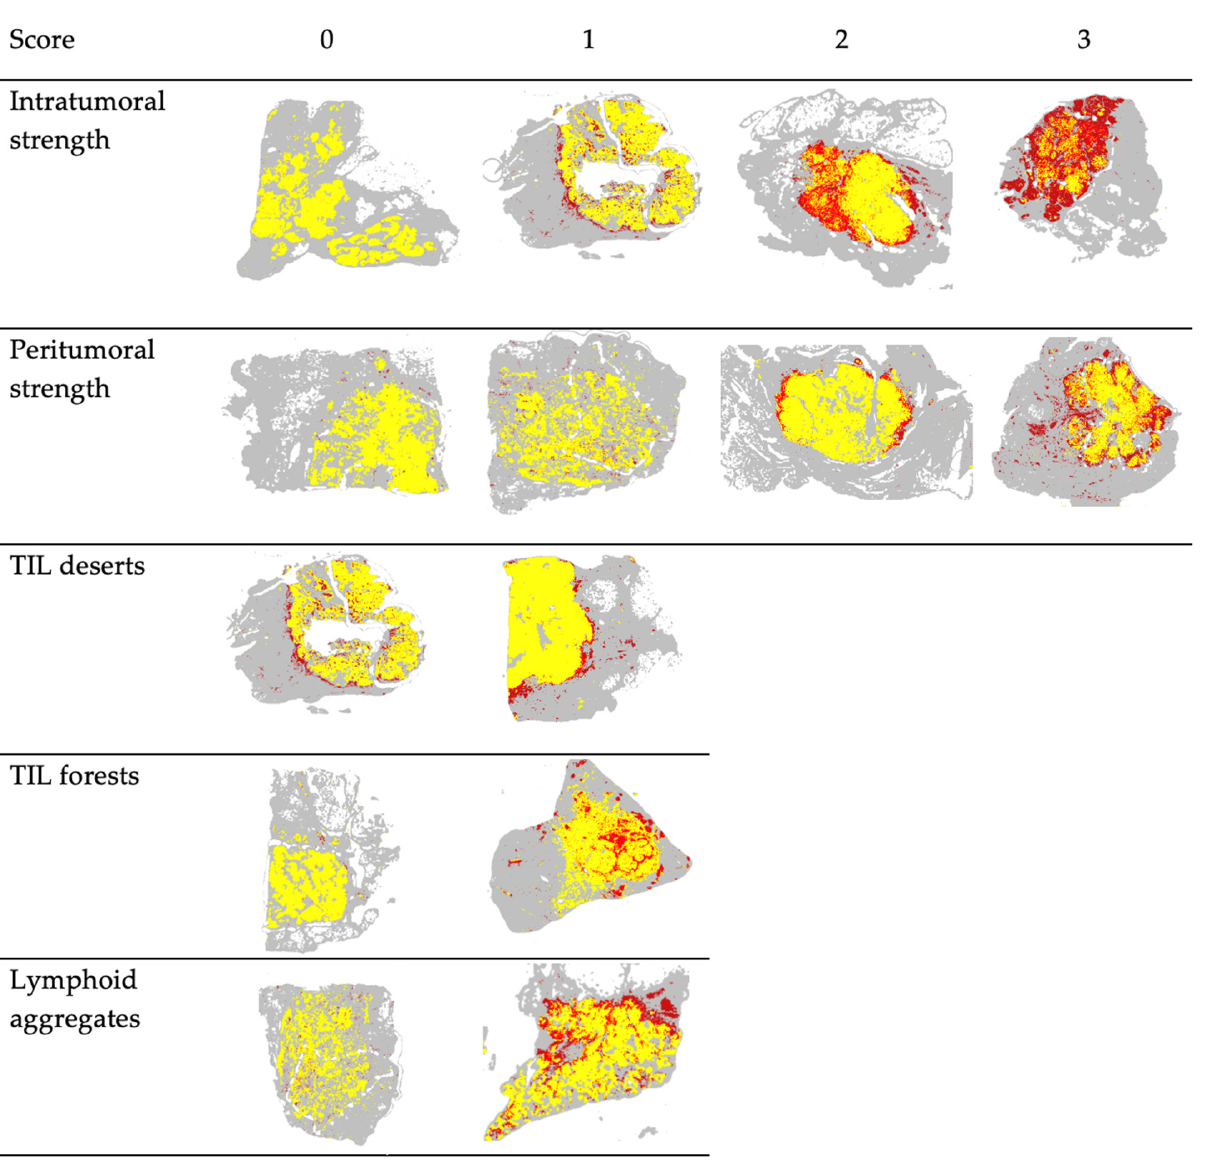
Figure 3. Representative Tumor-TIL maps from TCGA BRCA demonstrating the scoring paradigm for spatial features of TIL infiltrates. Scores of 0, 1, 2, and 3 correspond to terminology used by pathologists for grading, such as minimal, mild, moderate, and severe and/or 1+, 2+, and 3+. Detailed descriptions for scores (columns) for each category (rows) are found in Table 2. Red depicts lymphocytes, yellow depicts tumor regions, and gray represents non-tumor and non-lymphocyte background tissue